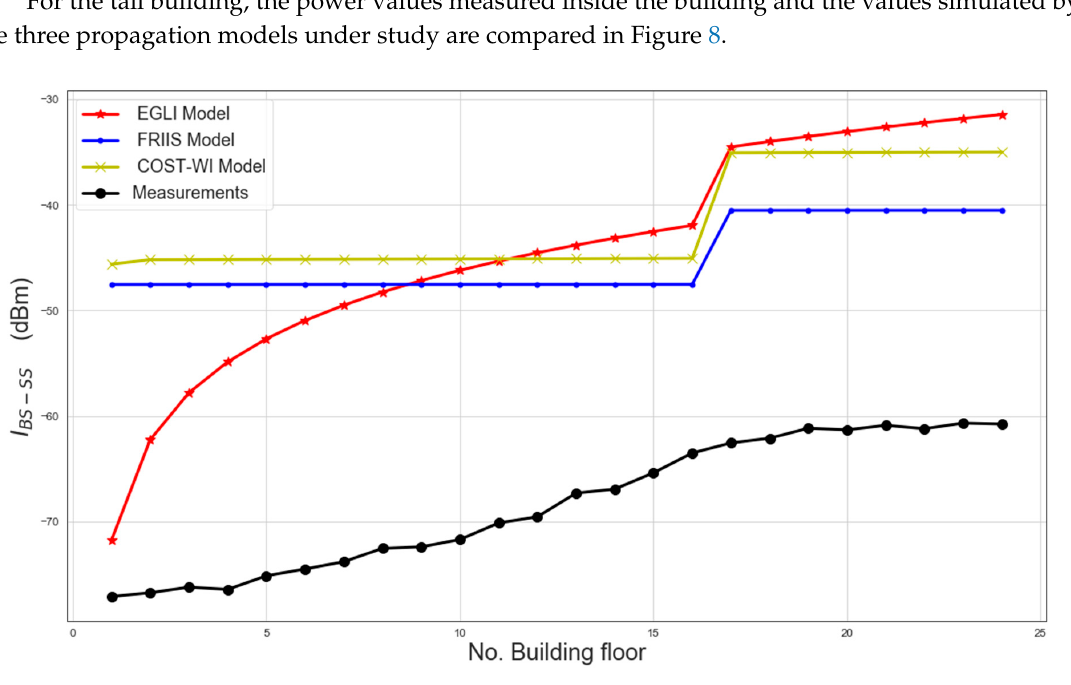
Figure 7. Simulated and measured interference levels received in the apartments located in the middle sector of the small building.